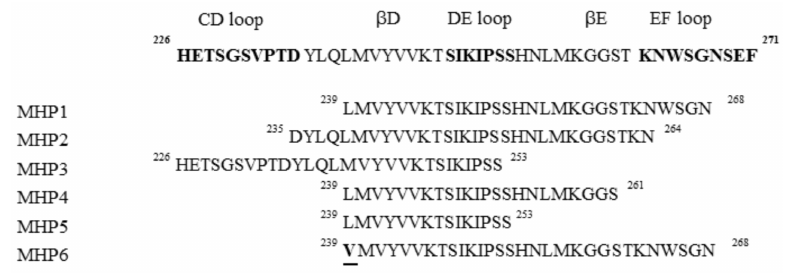
Figure 5. Sequences of microglial healing